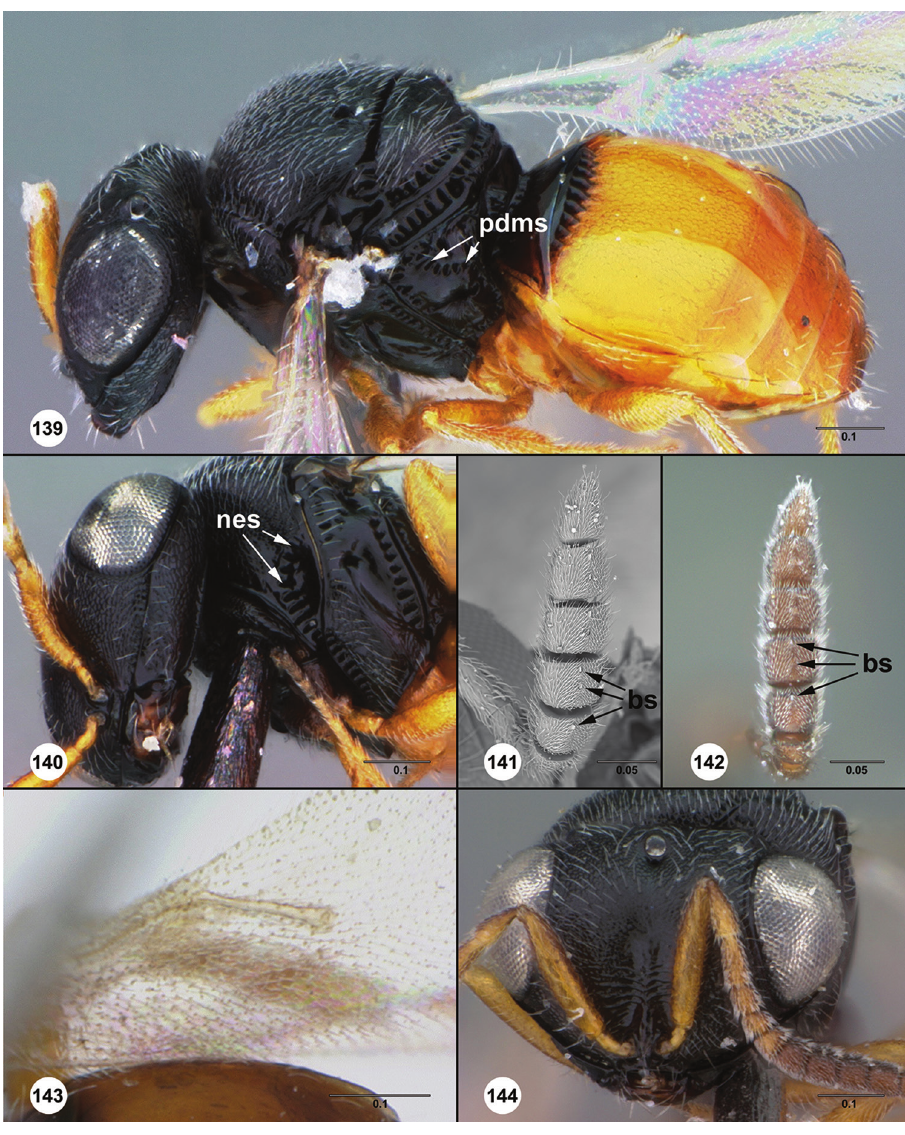
Figures 139–144. T. rufiventris 139 female (USNMENT01059199), head, mesosoma, metasoma, dor- solateral view 140 female (USNMENT01059197), head, mesosoma, ventrolateral view 141 female (US- NMENT00675886), antennal clava, ventral view 142 female (USNMENT00675886), antennal clava, ventral view 143 female lectotype (NHMW 0005), venation of fore wing, dorsal view 144 female (USN- MENT00989158), head, anterior view. Scale bars in millimeters. Metasoma. Longitudinal striae on T1 posterior to basal costae: present. Number of sublateral setae (on one side): 1. Setation of laterotergite 1: absent. Longitudinal striation of T2: absent; faintly present anteriorly. Setation of T2: sparsely present